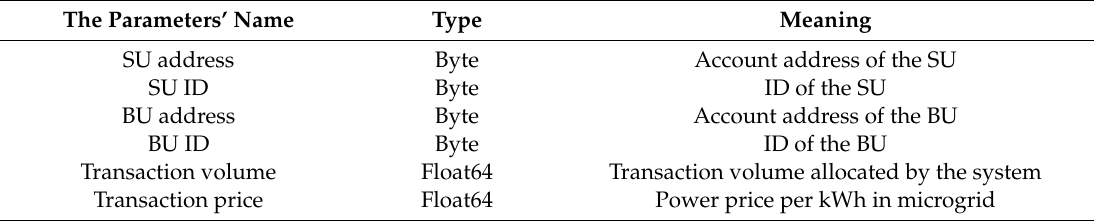
Table 5. Basic elements of the matchmaking transaction chaincode.